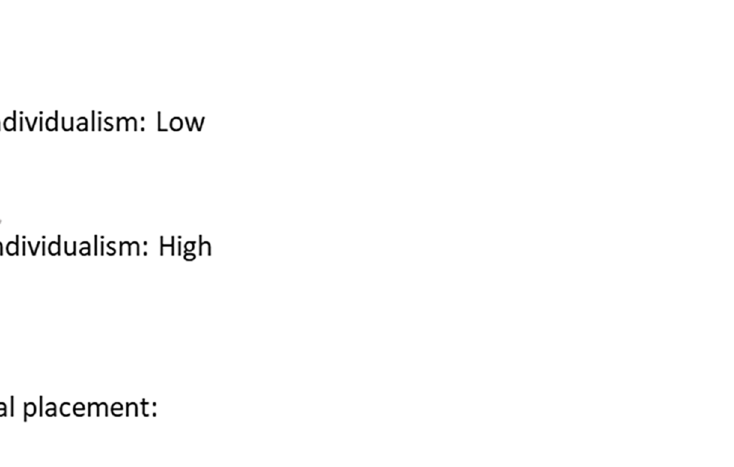
Journal of Social and Political Psychology 2020, Vol. 8(1), 132–150